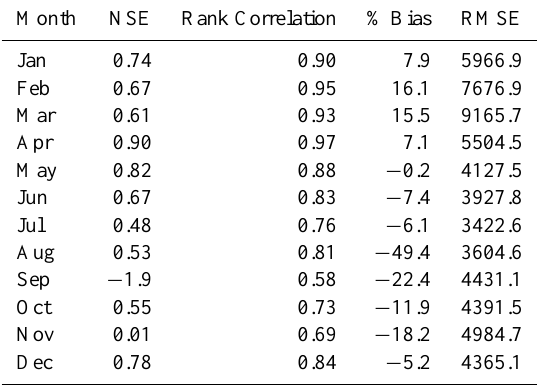
Table 2. VIC model calibration summary for the period 1957–1980. NSE represents Nash–Sutcliffe